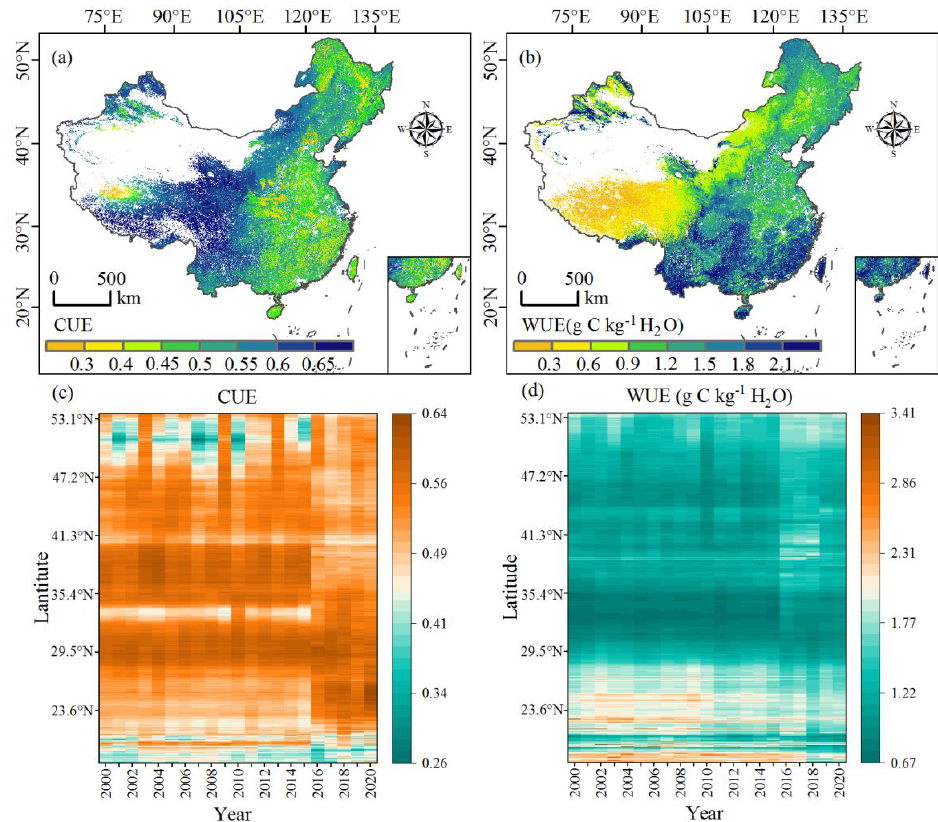
Figure 2. Spatial – distribution and latitudinal-variation characteristics of CUE and WUE in China Figure 2. Spatial–distribution and latitudinal-variation characteristics of CUE and WUE in China from from 2000 to 2020. ( a , b ) Spatial – distribution characteristics of CUE and WUE, ( c , d ) Latitudinal-var- 2000 to 2020. ( a , b ) Spatial–distribution characteristics of CUE and WUE, ( c , d ) Latitudinal-variation iation characteristics of CUE and WUE. characteristics of CUE and WUE.